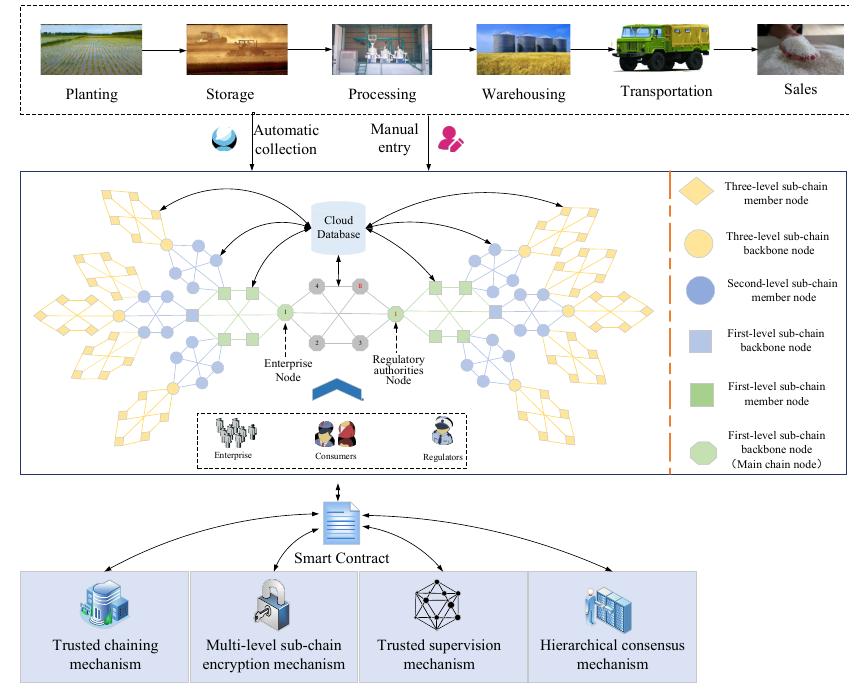
Figure 2. Information management and control model of rice supply chain.